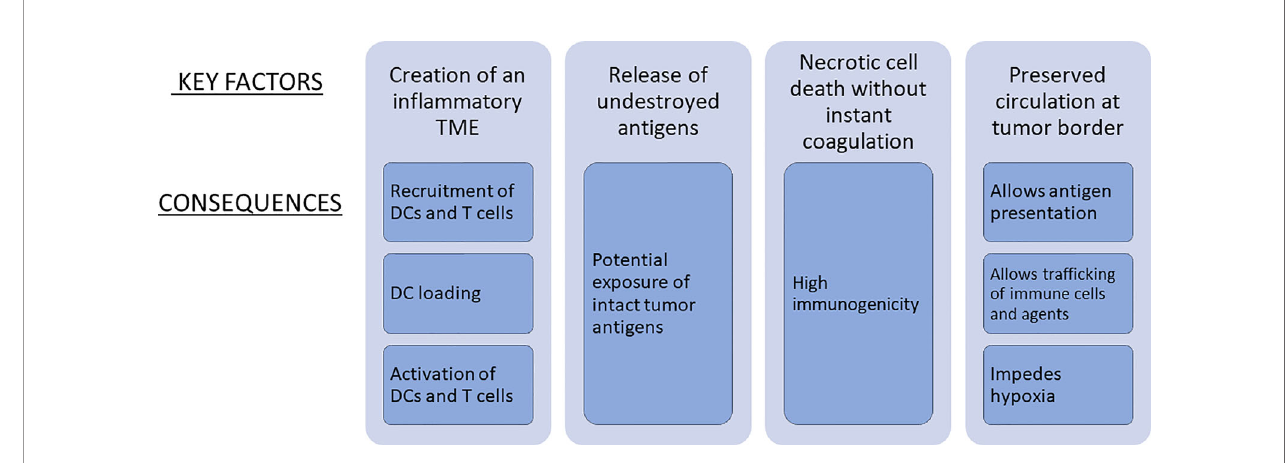
FIGURE 1 | Key factors for an abscopal effect of LTD when used alone and in combination